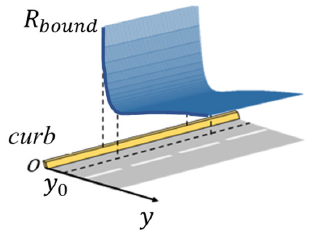
Figure 3. A risk distribution map of boundary risk field.